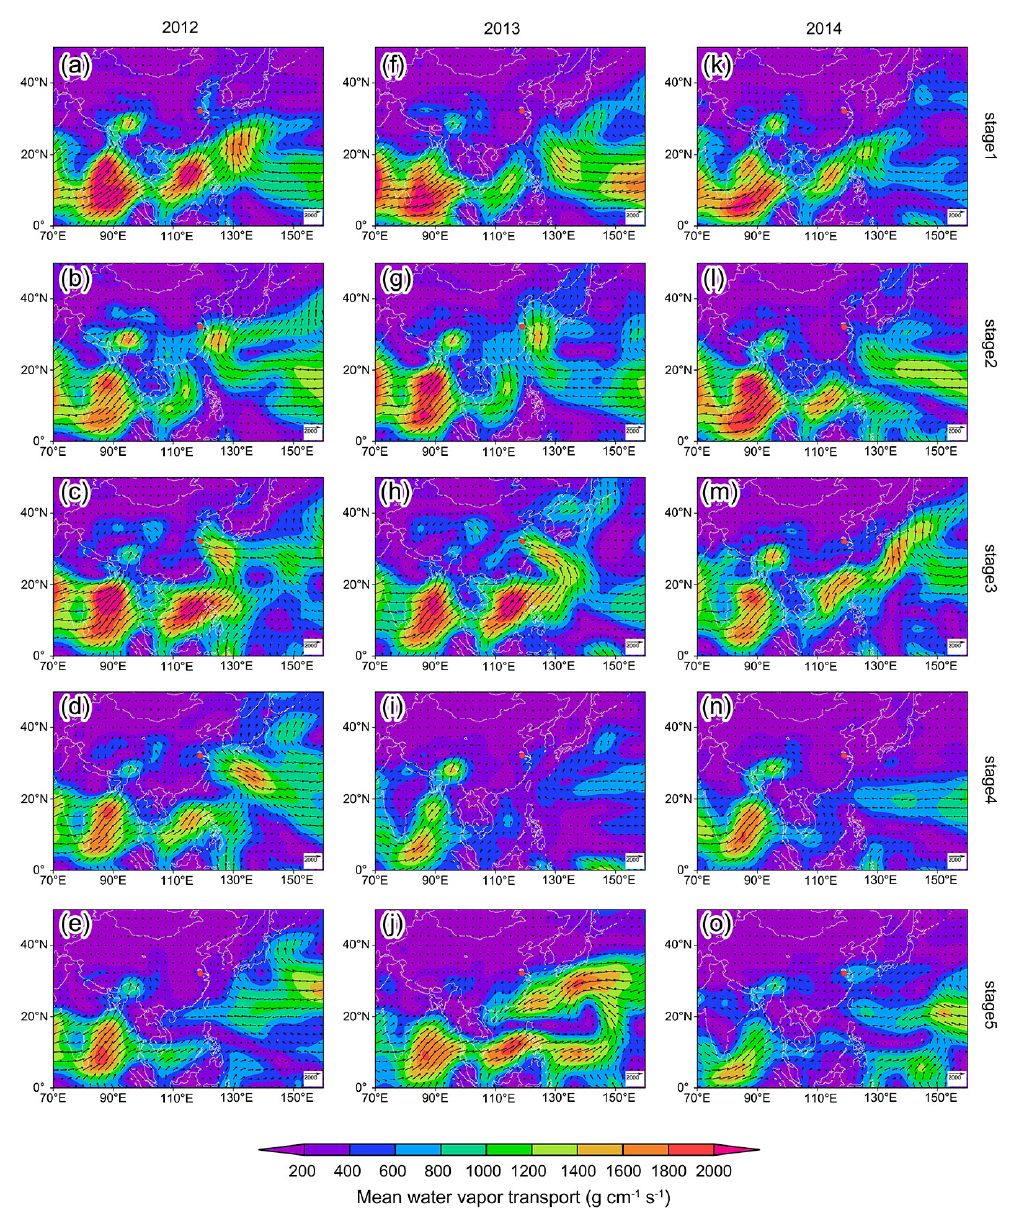
Figure 8. Vertically integrated mean water vapor transport (gcm − 1 s − 1 ) for stages 1–5 in 2012 (a–e) , 2013 (f–j) and 2014 (k–o) . Different colors indicate the magnitude of the moisture flux vector. The study site of Nanjing is marked by the red